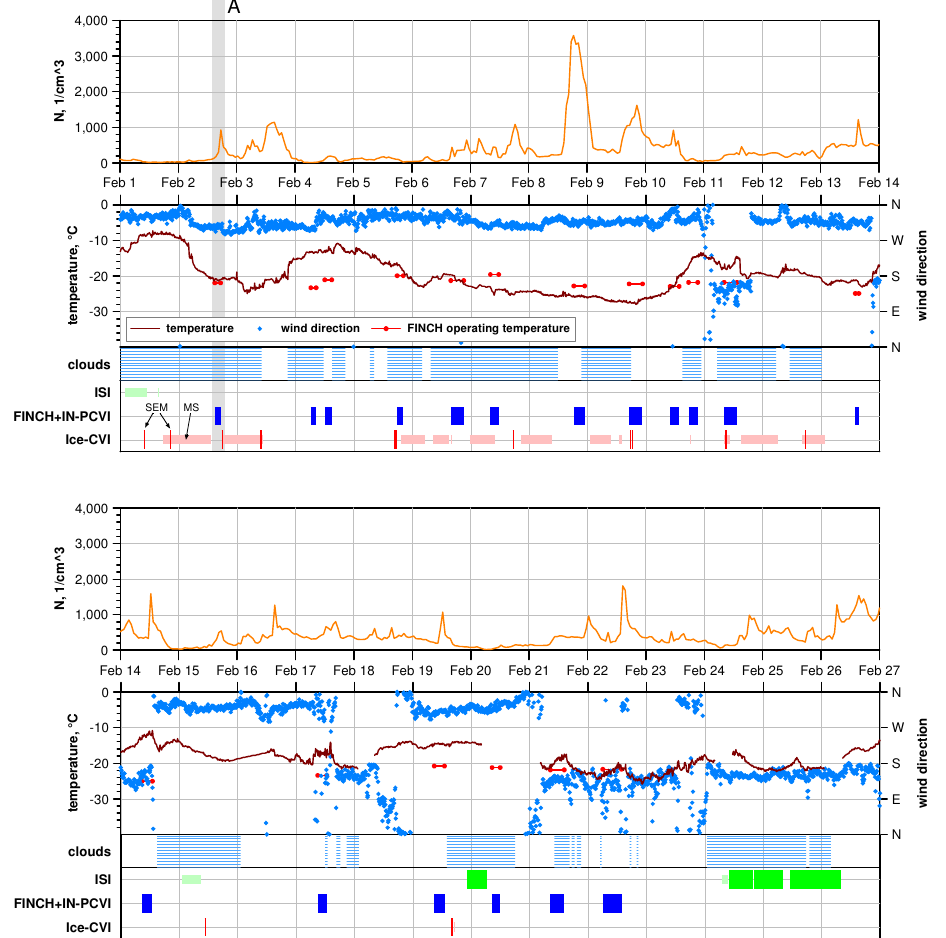
Figure 1. Atmospheric and FINCH operating conditions and INP/IPR sampling periods in February 2013. Times are given in UTC. Particle number concentrations were taken from the World Data Centre for Aerosols home page (WDCA, 2014). Temperature and wind direction were provided by the Jungfraujoch station operated by International Foundation High Altitude Research Stations Jungfraujoch and Gornergrat. Cloud presence was detected by measuring the liquid water content using a Particulate Volume Monitor (PVM-100, Gerber Scientific, Reston, VA, USA) and a Cloud Droplet Probe (Droplet Measurement Technologies, Boulder, CO, USA). Sampling phases for SEM are marked by wide, intensely colored bars; sampling phases for MS are shown as narrower, pale-colored bars. “A” marks a period used for case